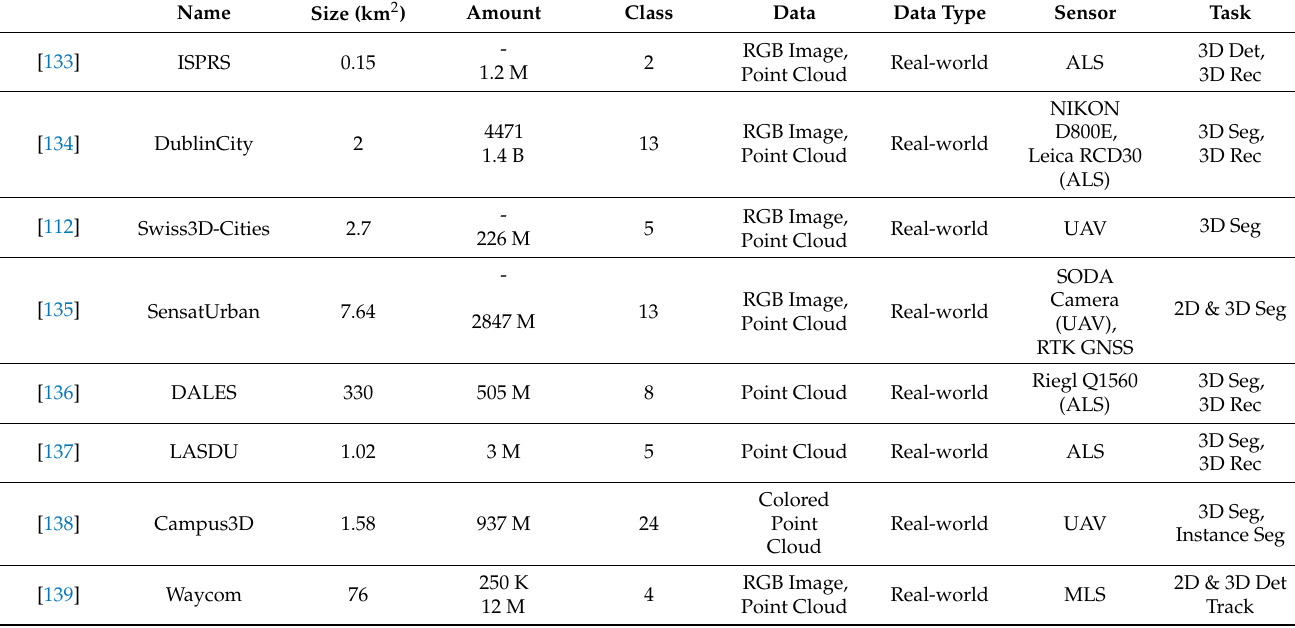
Table 5. Comparative summary of outdoor road-level datasets (Seg: segmentation; Rec: recognition; Cla: